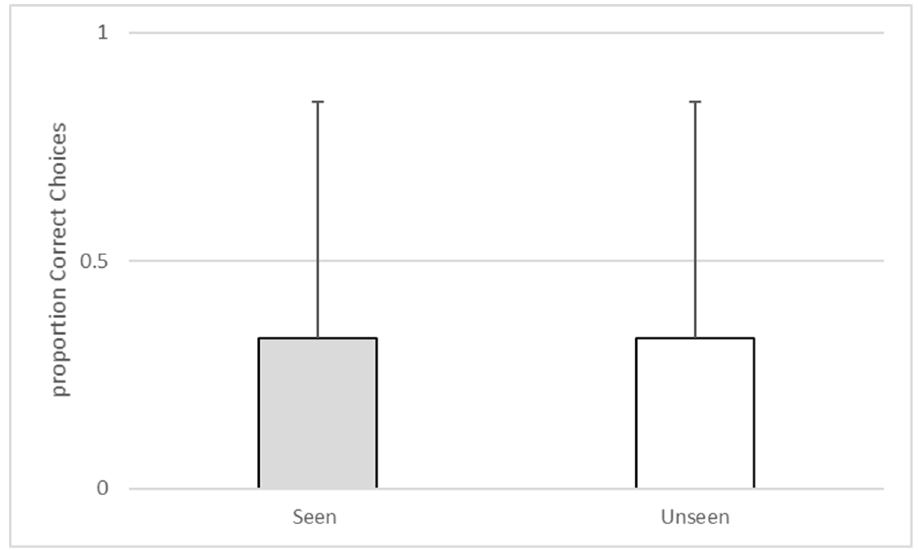
Figure 6. The proportion of correct choices during seen versus unseen trials during Experiment 2.